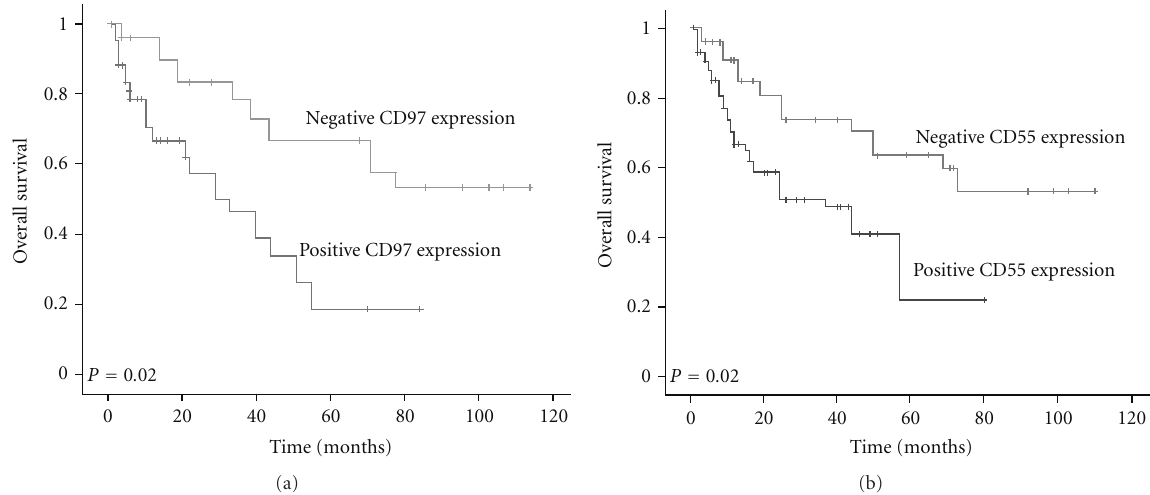
Figure 2: Correlation of CD97 (a) and CD55 (b) expression with the overall survival rates in 138 patients with GBC (compared with log-rank test).